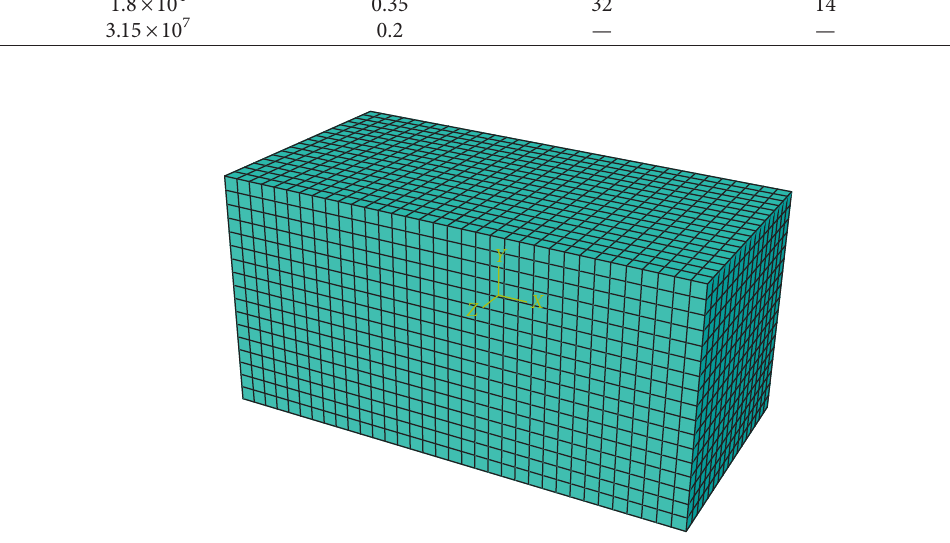
Figure 6: FEA model of model